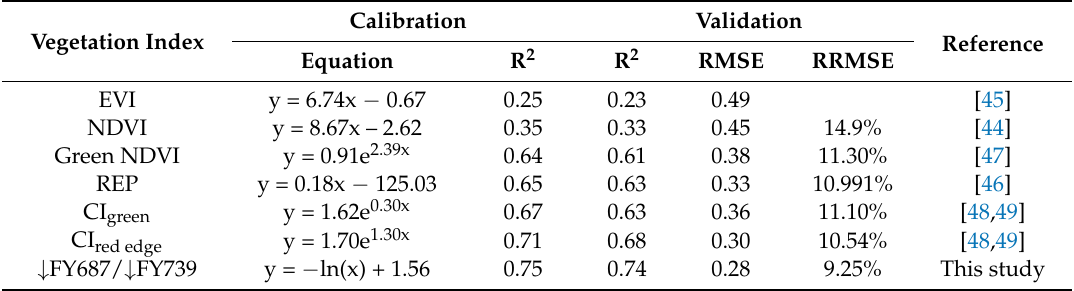
Table 4. Better performing LNC models based on vegetation indices in the calibration and validation. Vegetation Index Vegetation